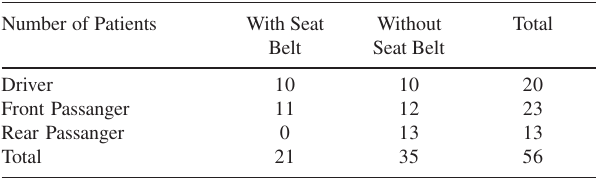
Table 1 - Number of patients per group. Number of